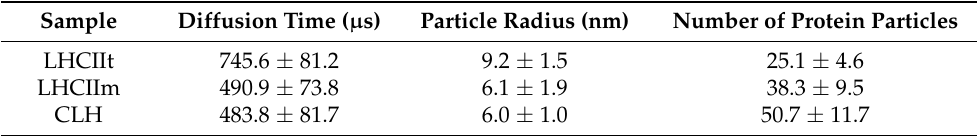
Figure 1. Oligomerization state of light-harvesting antennas estimated from autocorrelation corre- lation functions (ACFs) in microscopic Fluorescence Correlation Spectroscopy. Isolated antennas of trimeric LHCII (LHCIIt), monomerized LHCII (LHCIIm) and CLH antennas were measured in conditions of high pH (7.3) and high detergent concentration DDM (200 µ M). ( A ) Averaged ACFs (G ( τ )) for antenna proteins in solution. Data represent the results of the fitting. See Supplementary Figure S1 for raw traces and residuals. ( B ) Radius of the antenna particles as calculated from ACFs (see Materials and Methods). Data represent averages and standard deviations of 7 independent mea- surements. All samples were measured at the same OD 676. A double asterisk marks very statistically different data groups; ns = not statistically different. Table 1. Diffusion times, inferred radius, and number of light-harvesting antenna particles. The parameters were calculated from ACFs obtained by FCS (see Figure 1). Data represent averages and standard deviations for 7 independent